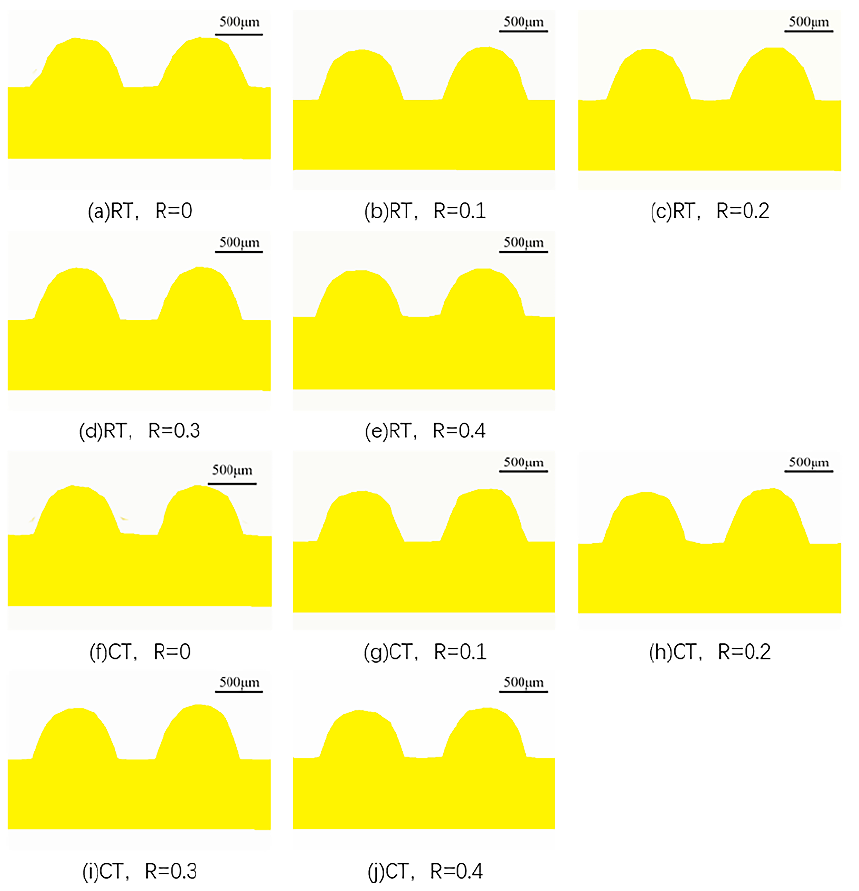
Figure 26. Cross-sectional area of three-dimensional morphology of micro-groove fins produced by extrusion machining under different conditions.